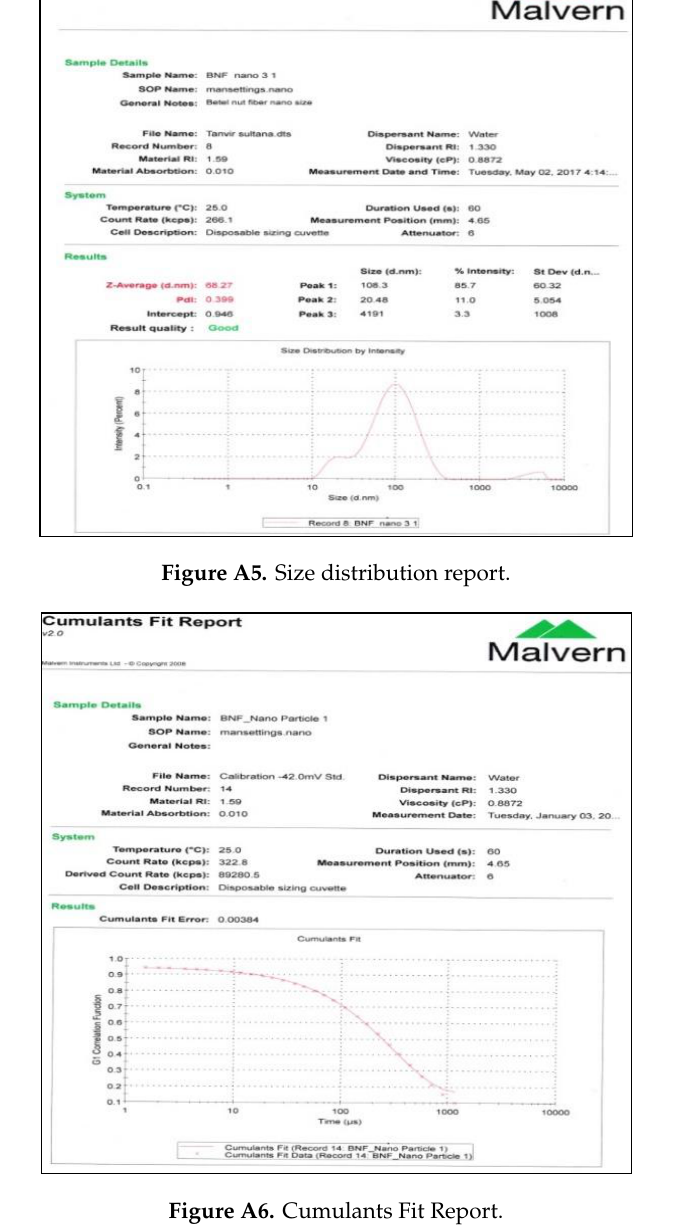
Figure A6. Cumulants Fit Report.